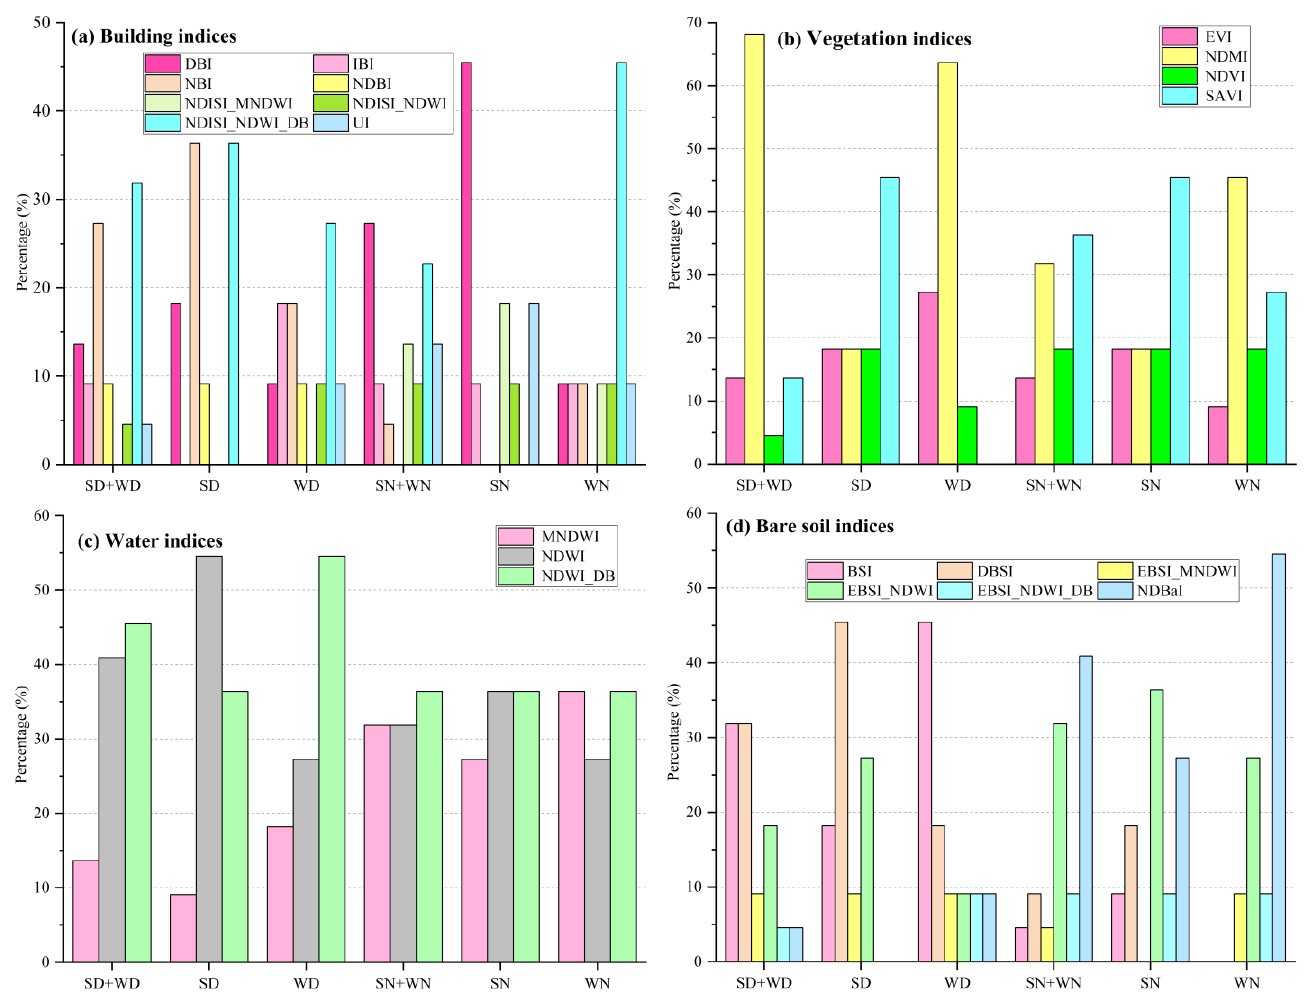
Figure 3. The percentage of the building ( a ), vegetation ( b ), water ( c ) and bare soil indices ( d ) to show the largest correlation with land surface temperatures. SD, WD, SN and WN refer to the summer daytime, winter daytime, summer night and winter night, respectively.